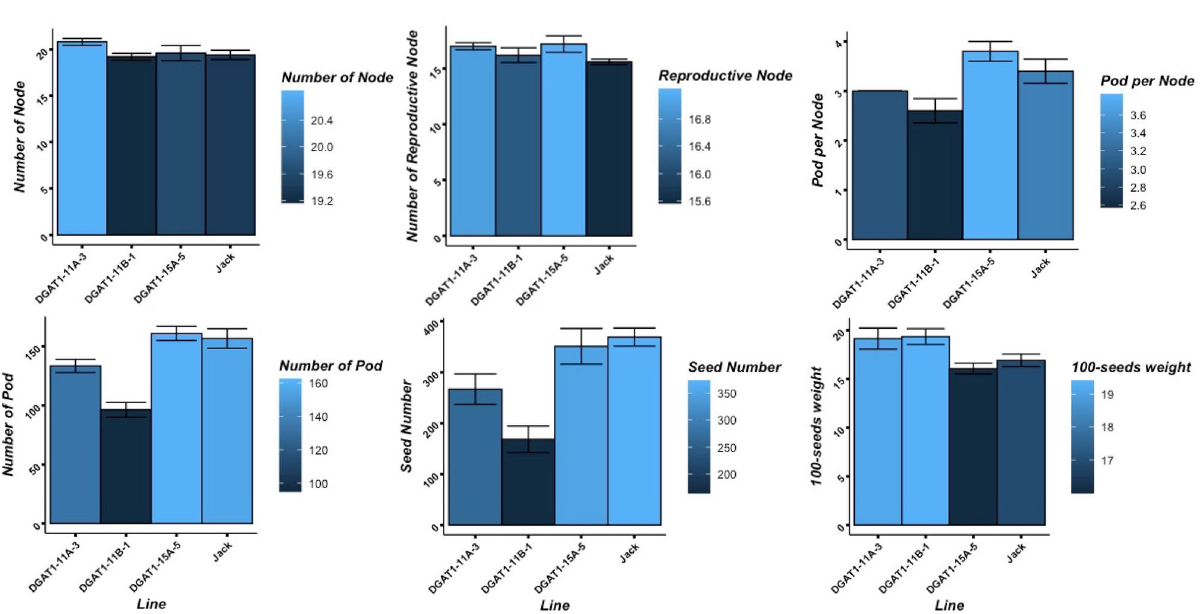
Figure 7. Functional influence of DGAT1 down-regulation on morphological traits in transgenic lines and wild-type soybean, cv. Jack, at maturity stage before and after harvesting. The presented values are mean ± SE measured using three independent